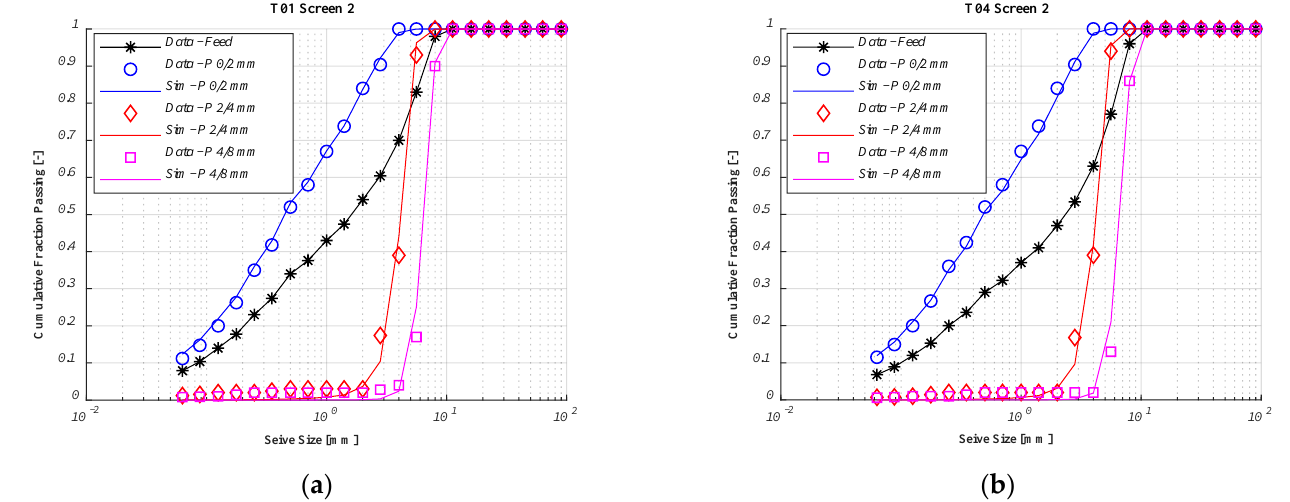
Figure 12. Screen 1 calibration results for ( a ) T01 and ( b ) T04 in the cumulative domain.